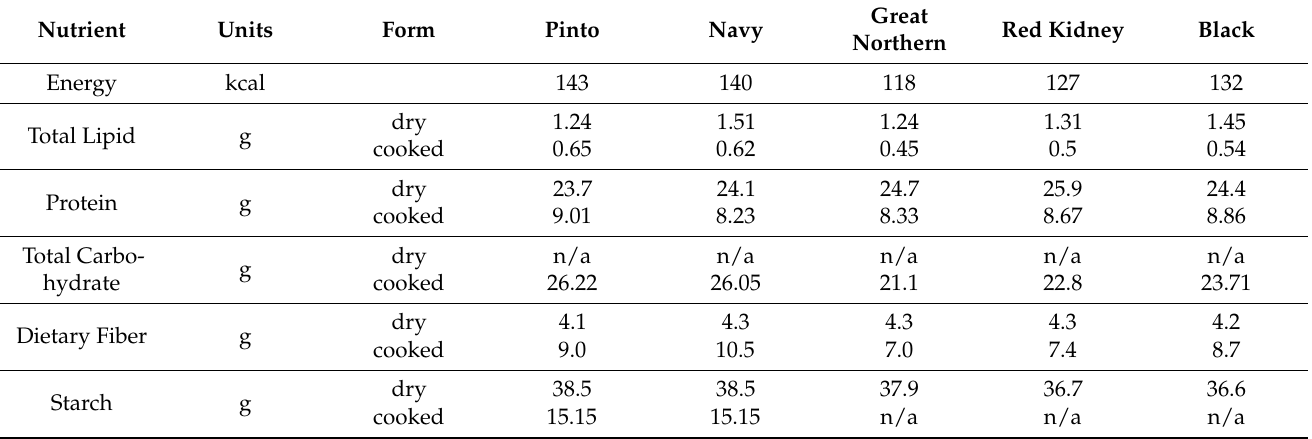
Table 1. Macronutrient content of common beans in 100 g of edible